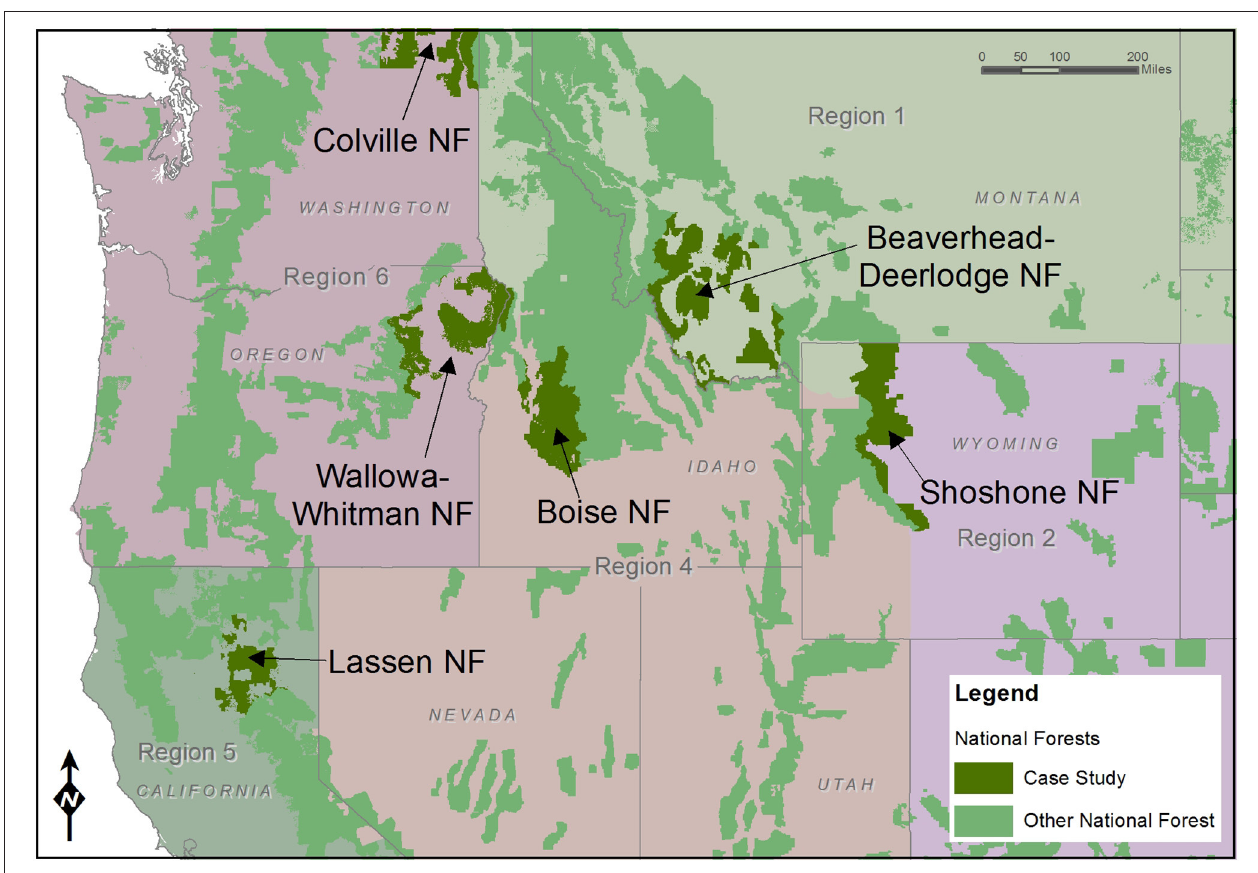
FIGURE 2 | Case study forests and context